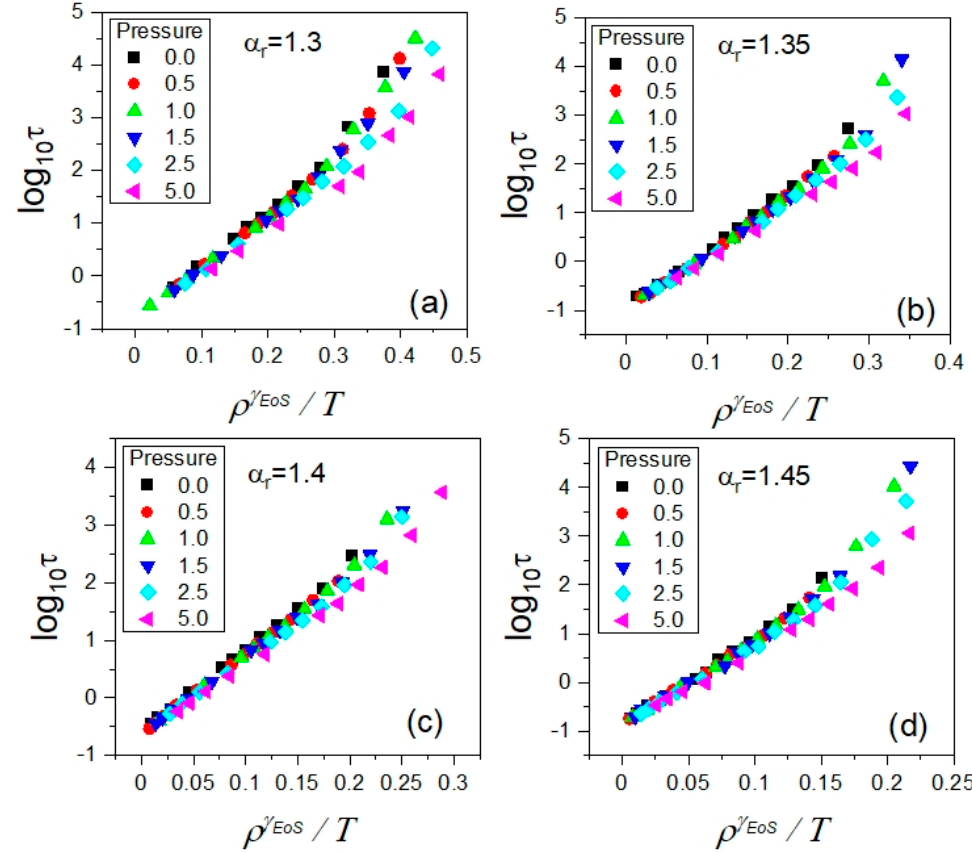
Figure 4. Plots of the attempts at employing the values of the density scaling γ EoS found as the fitting parameter of the EoS given by Equation (3) in the implementation of the density scaling of translational relaxation times τ collected in the supercooled liquid state in the GB model for all tested anisotropy aspect ratios α r , which are presented in the separate panels for different values of α r : ( a ) 1.30, ( b ) 1.35, ( c ) 1.40, and ( d ) 1.45, respectively. The values of γ EoS are collected in Table Since the test of the density scaling represented in Figure 4 has failed, one could even suspect the invalidity of the density scaling of translational relaxation times in the super- cooled liquid state in the GB model. To verify this issue, we used the fundamental formula ( ) log T τ that is the density scaling criterion. To apply Equation (2) to the dependences 10